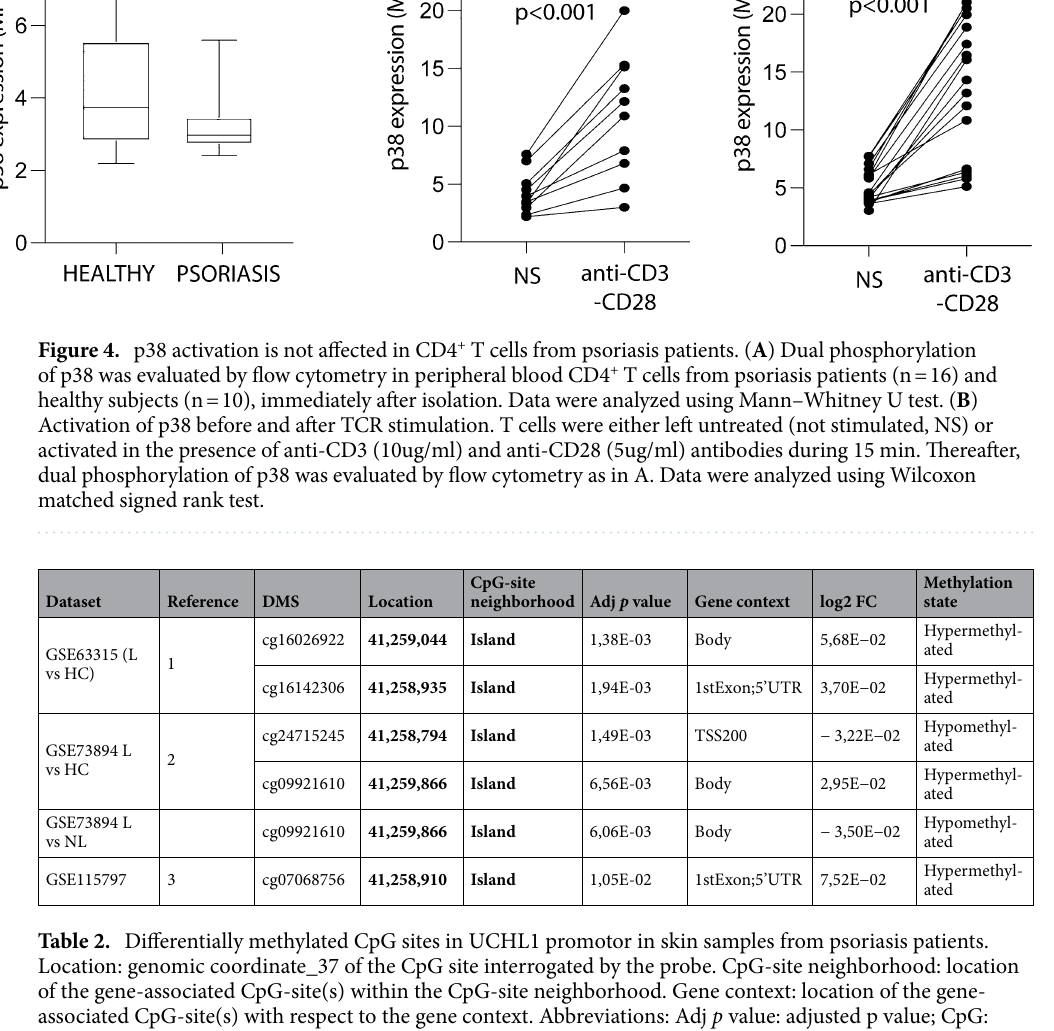
environment, we did not observe any difference in the activation of the p38 pathway compared to controls. The opposing effects of GADD45a and GADD45b molecules on T cell activation may counterbalance and account